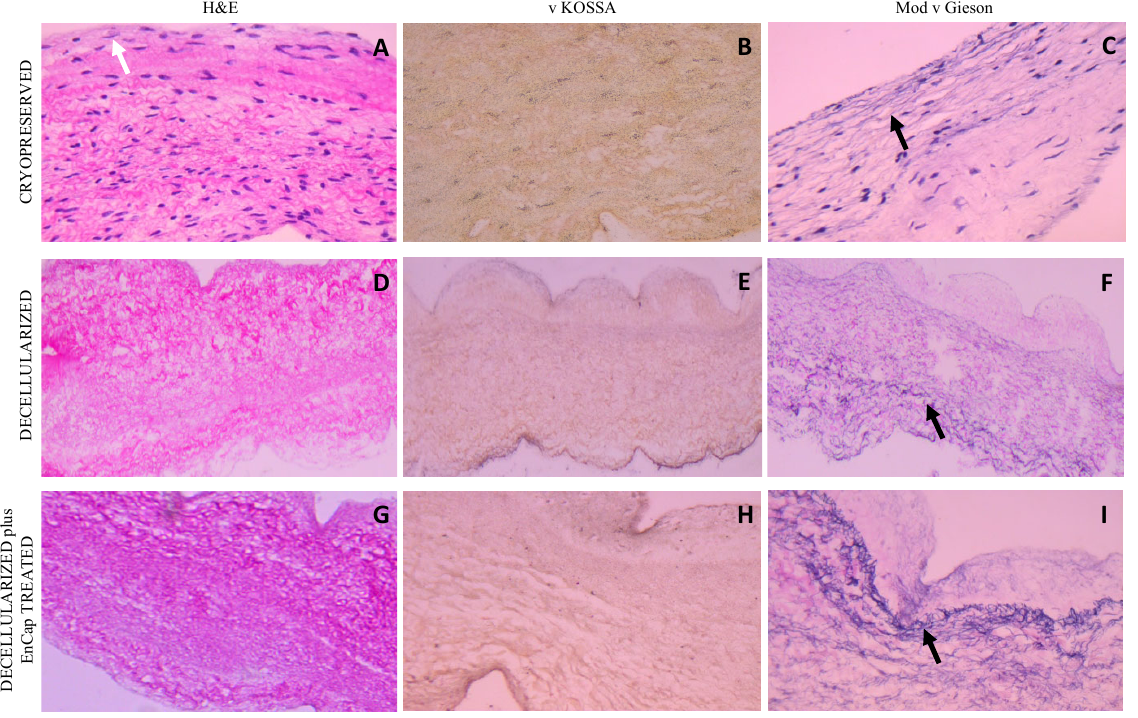
Figure 4. Representative H&E, von Kossa, and modified Verhoeff’s van Gieson staining of cryopreserved, decellularized, and decellularized and EnCap TM ‐ treated leaflet samples processed after 48 h cold ischaemia; white arrow points to endothelial layer, and black arrows point to normally distributed elastic fibers (( A – I ) = 400× magnification).